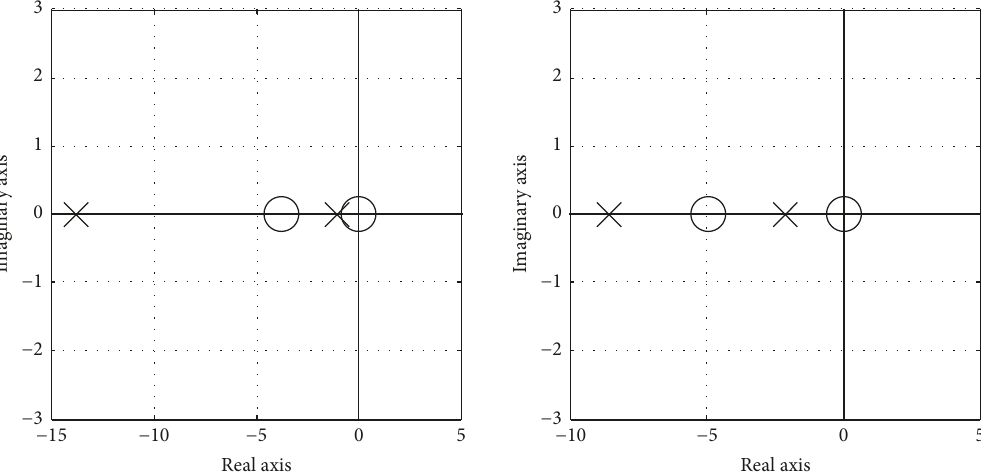
Figure 7: Robust nonfragile H ∞ control for vehicle body head-shaking acceleration. (a) Without perturbation. (b) With perturbation.